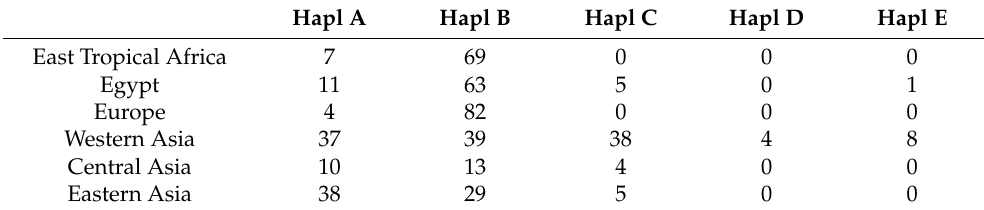
Table 2. Distribution of the haplogroups in the breeds in the different regions. Hapl A Hapl B Hapl C Hapl